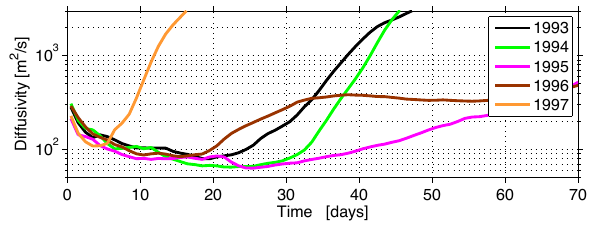
Fig. 14. Simulated diffusivity diagnosed (with Eq. 5) from the effec- tive area covered by the released 137 Cs patch. Day zero corresponds to the time of release in the respective nominal years indicated by the figure legend.